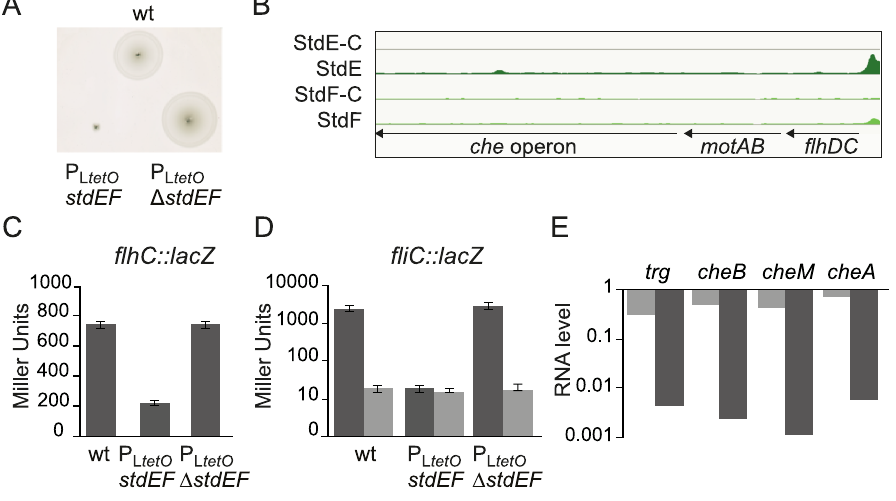
Fig 4. Flagellar control by StdE and StdF. A. Motility of strains SL1344 (wt), P L tetO - stdEF (SV8141) and P L tetO - Δ stdEF (SV8142). The experiments were performed for at least three biological replicates, and a representative experiment is shown. B. StdE and StdF binding peaks in the flhDC region. StdE-C and StdF-C indicate binding peaks found for the mock IP-sample. C. β -galactosidase activity of a flhC :: lac Zfusion. Constitutive expression of stdEF (SV9289) results in low level of flhC expression, compared with the wild type strain (SV9288) and with the control strain P L (SV9290). D . β -galactosidase activity of a fliC :: lacZ fusion showing that StdE and StdF regulation of the flagellar system take place through FlhDC. Dark grey bars represent FlhC + and light grey bars represent FlhC – . E . Ratios (P L P L tetO - Δ stdEF) of mRNA levels of genes involved in chemotaxis in the strains P L tetO - stdEF and P L tetO - Δ stdEF .RNA levels were determined for at least 3 biological replicates and a representative experiment is shown. As above, dark grey bars represent FlhC + and light grey bars represent FlhC –